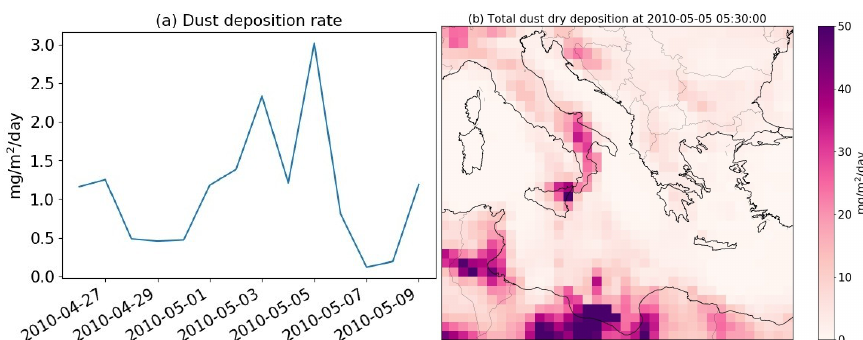
Figure 4. MARRES-2 reanalysis using GEOS-5 of dust deposition at Zagreb area from 24 April to 5 May in 2010 with visible maximum of dust on 5 May ( a ), and dust deposition over Mediterranean area, including Croatia, i.e., Zagreb area, at 5 May 2010 at 05:30. GEOS-5 system [63] has a resolution of 50 km, and forecast the dust, sea salt, POC, black carbon, and sulfates [64] .